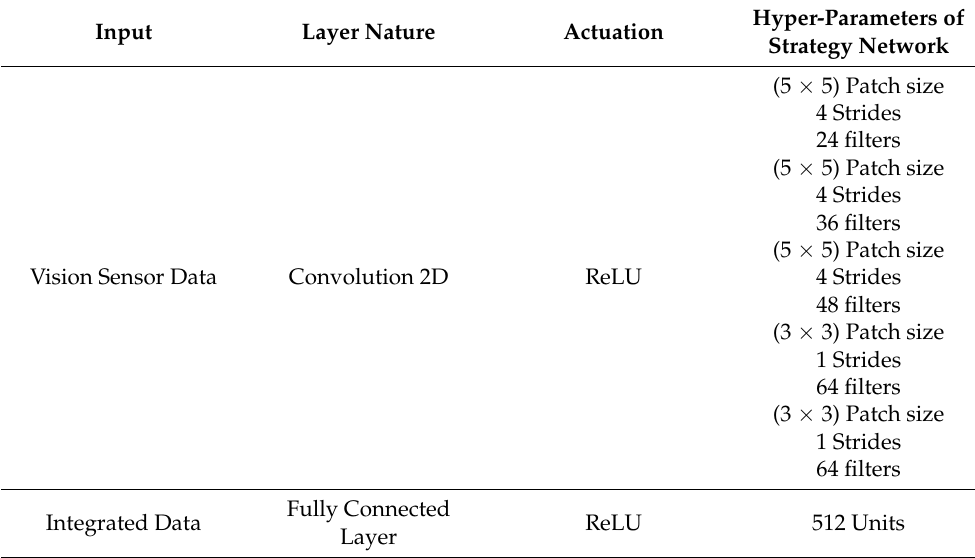
Table 1. Autonomous propulsive approach network: